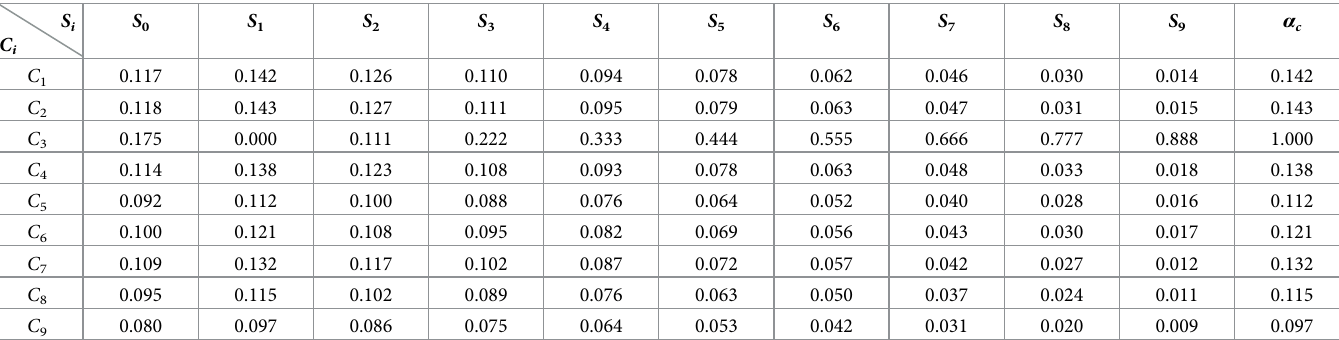
Table 5. Weights of criteria in nine scenario for sensitivity